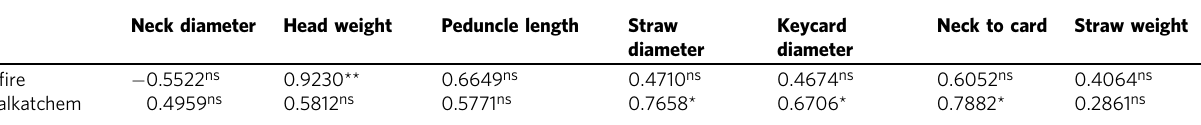
The sample size of each cultivar is 9, including samples collected from three sulfur treatments with three biologically independent replicates (or three pots) for each sulfur treatment; the number of biologically independent replicate (or pot) for each cultivar under each sulfur treatment is 3; r > 0.666, P < 0.05; r > 0.798, P < 0.01; * P < 0.05, ** P < 0.01; ns not signi fi cant. The correlation coef fi cient values r ofheadweightforSpit fi re,strawdiameter,keycarddiameter,andnecktocarddistanceforWyalkatchemwithgrainyield(nitrogen-useef fi ciency)werestatisticallysigni fi cantin2014glasshouse